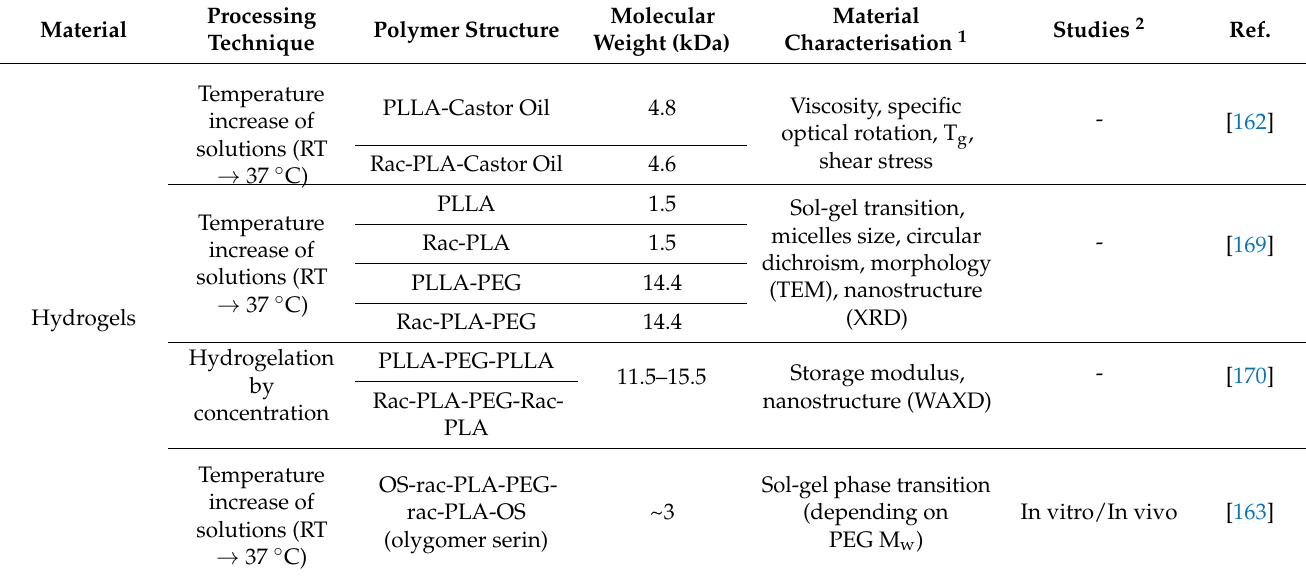
Table 2. Summary of PLA-derivative